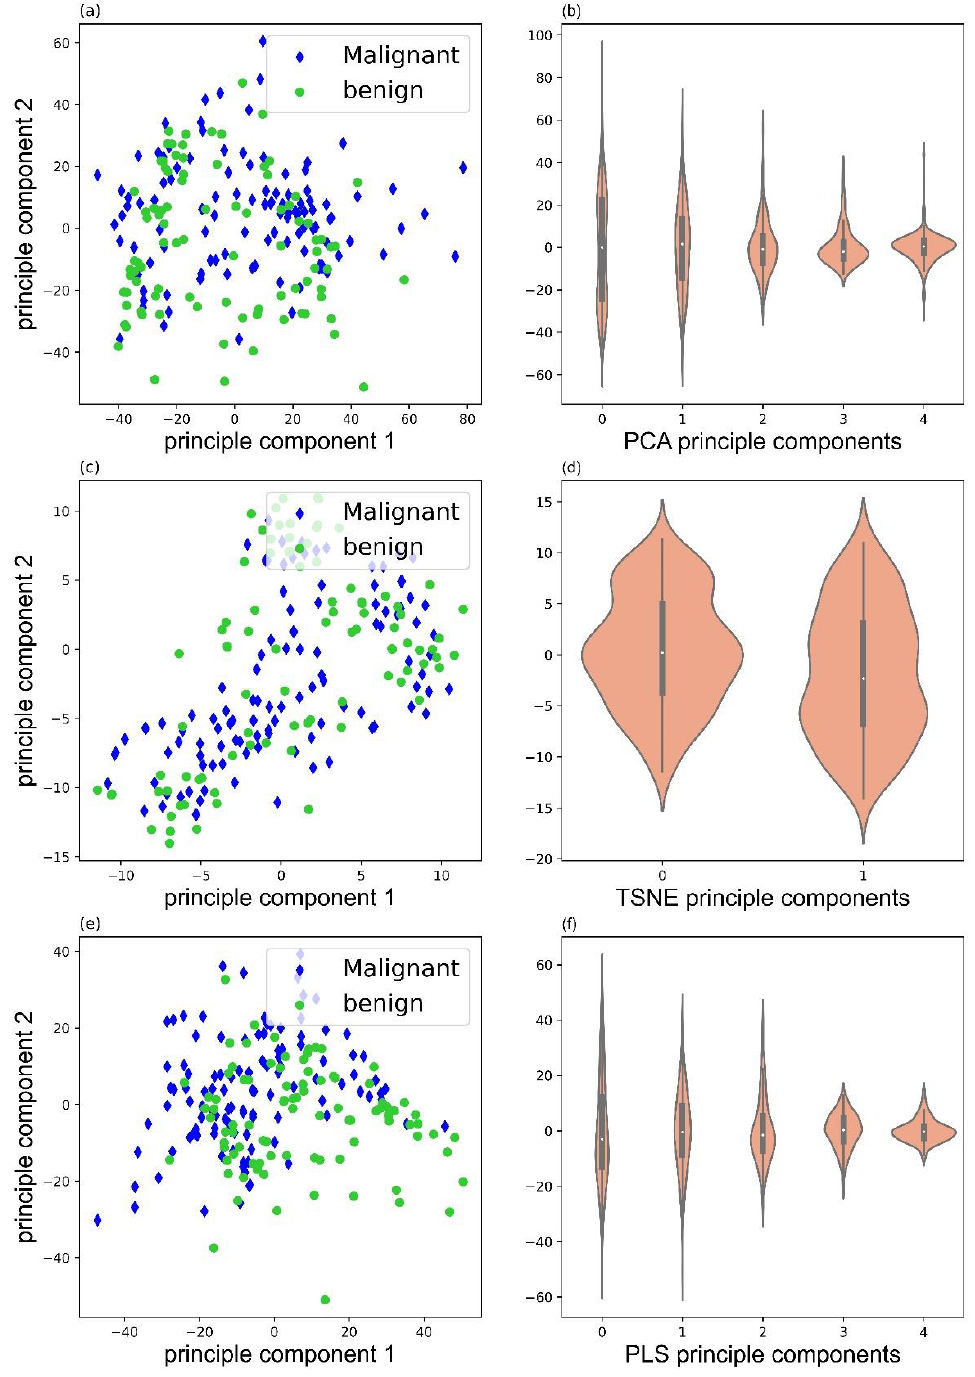
Figure 3. Score plots of PCA ( a ), TSNE ( c ), and PLS ( e ), and violin plots of PCA ( b ), TSNE ( d ), and PLS ( f )